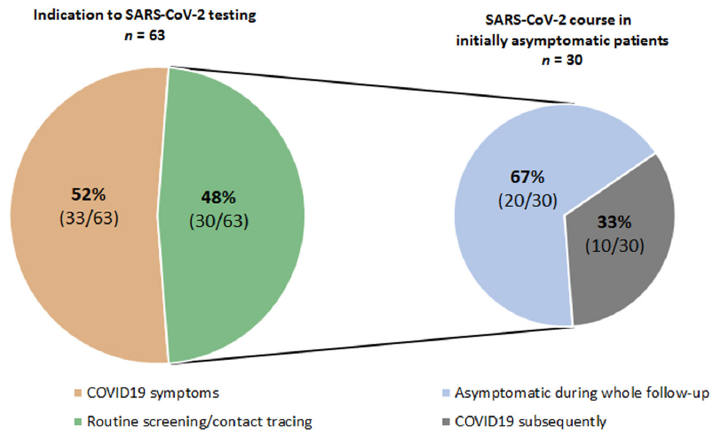
Figure 1. Indication for SARS-CoV-2 testing.